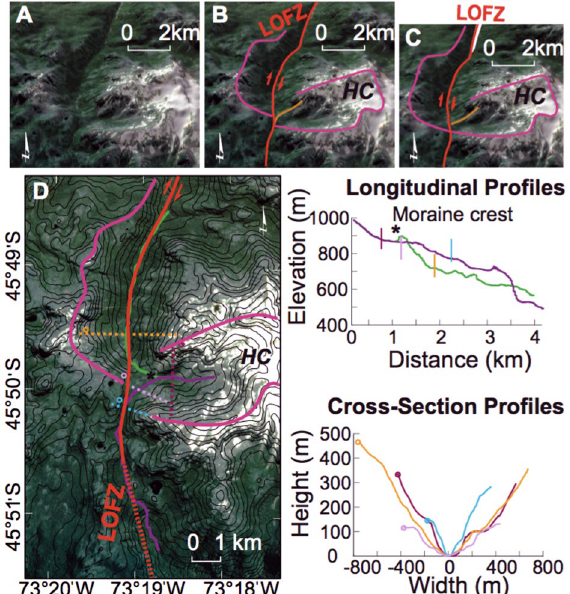
Figure 5. ( A ) Huemules Cirque (HC) setting based on ALOS PALSAR 30-m imagery. ( B ) Key features including the LOFZ and the outline of valley margin. ( C ) Retrodeformed model with the valley margin back- slipped along the LOFZ by 400 m which realigns the glacial valley to when it was last fully occupied by ice during the LGM (at least 17.3 ka). ( D ) Map showing locations of key elements and topographic profiles. ( E ) Topographic profiles. Note that the yellow and orange profiles provide a profile of the glacial Humules Valley and are now offset along the LOFZ have an excellent fit. Thus rapid LOFZ dextral motion (i.e. 21.7 to 24.6 mm/ year) is causing the Huemules Valley to be almost beheaded from the HC. Field and helicopter photos from this site are shown in Fig. 6. Base hillshade was generated with Esri ArcMap v.10.3 software (under fair terms of use, https:// www. esri. com/ en- us/ legal/ copyr ight- trade marks) 39 using a digital elevation model downloaded from ALOSPALSAR Global Radar Imagery 40 with 12.5 m resolution (https:// asf. alaska. edu/ data- sets/ sar- data- sets/ alos-